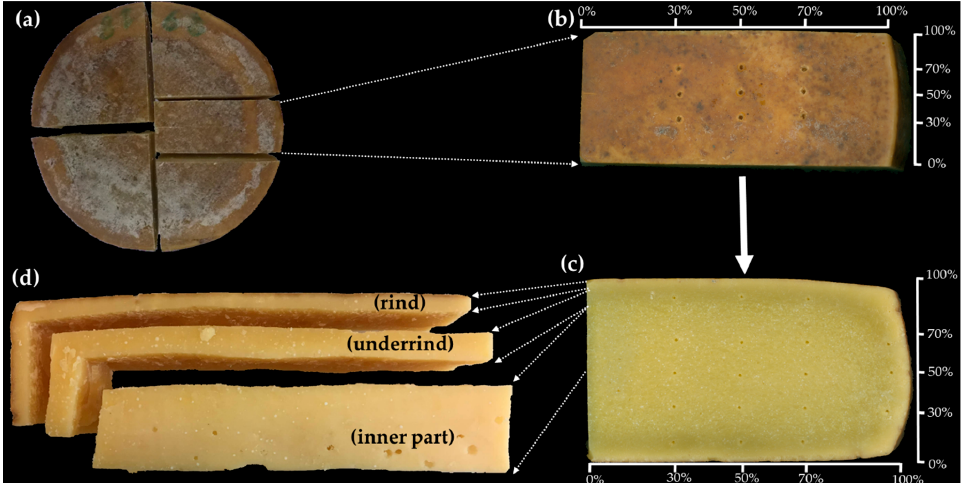
Figure 2. Cheese sampling and analysis schematization. ( a ) cheese wheel seen from the top: portioning of a representative slice; ( b ) focus on the rind: specific textural and color analysis points at 30–50–70% of slice length and thickness; ( c ) focus on the underrind and inner part: specific textural and color analysis points at 30–50–70% of slice length and height; ( d ) cheese zones subdivision: rind, underrind (part with a depth between 0.5 cm and 1.5 cm) and inner part.